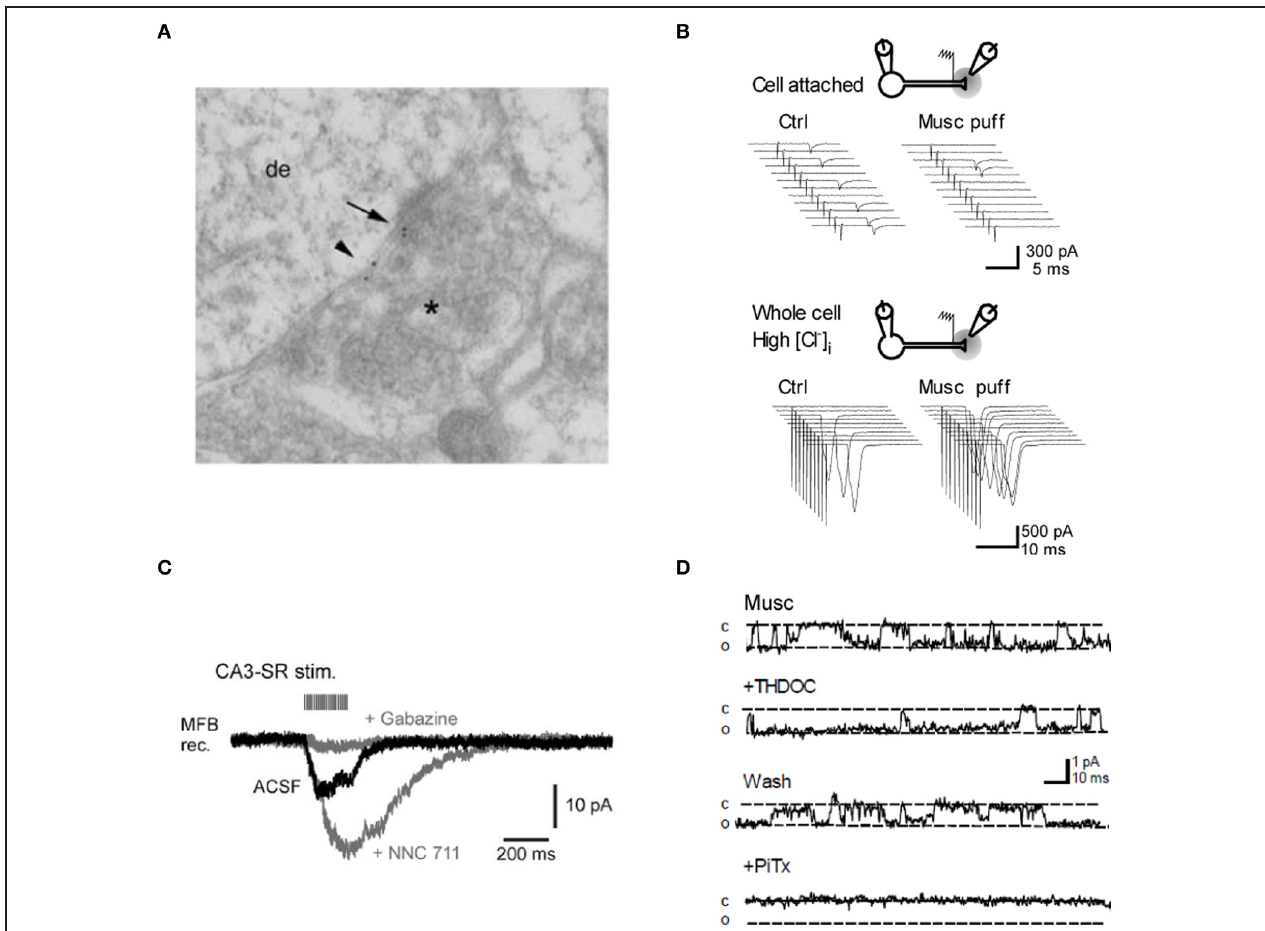
FIGURE 2 | Evidence for GABA A receptors modulating mossy fiber excitability. (A) Post-embedding immunolocalization of the GABA A receptor subunit α 2 in a presumptive large mossy fiber terminal. (Asterisk indicates the presynaptic profile). Labeling is present at the synaptic cleft (arrow) and at extrasynaptic axonal membranes (small arrowhead). (B) Top, intermittent antidromic action currents. Local pressure application of the GABA A agonist muscimol close to the stimulation site decreased the axon excitability. Bottom, following “break-in” with a pipette containing a high [Cl − ], the same application of muscimol caused an increase in axon excitability. Sweeps on the right are from one example cell. (C) Spill-over GABA A receptor-mediated